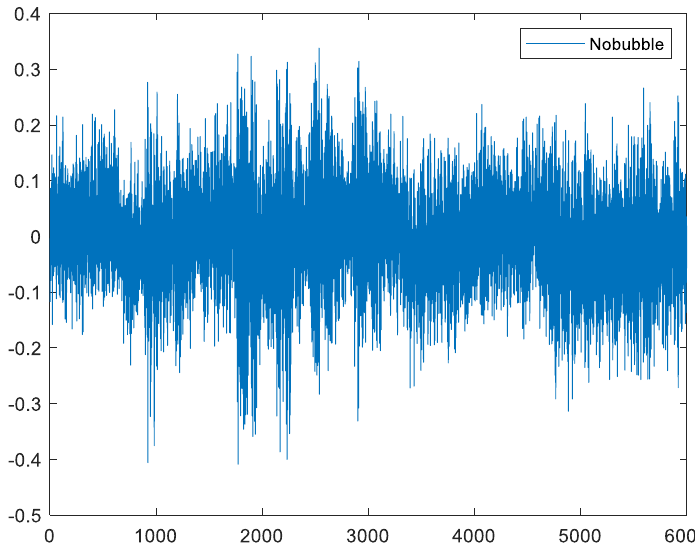
Figure 3. Wavelet output of a healthy signal.